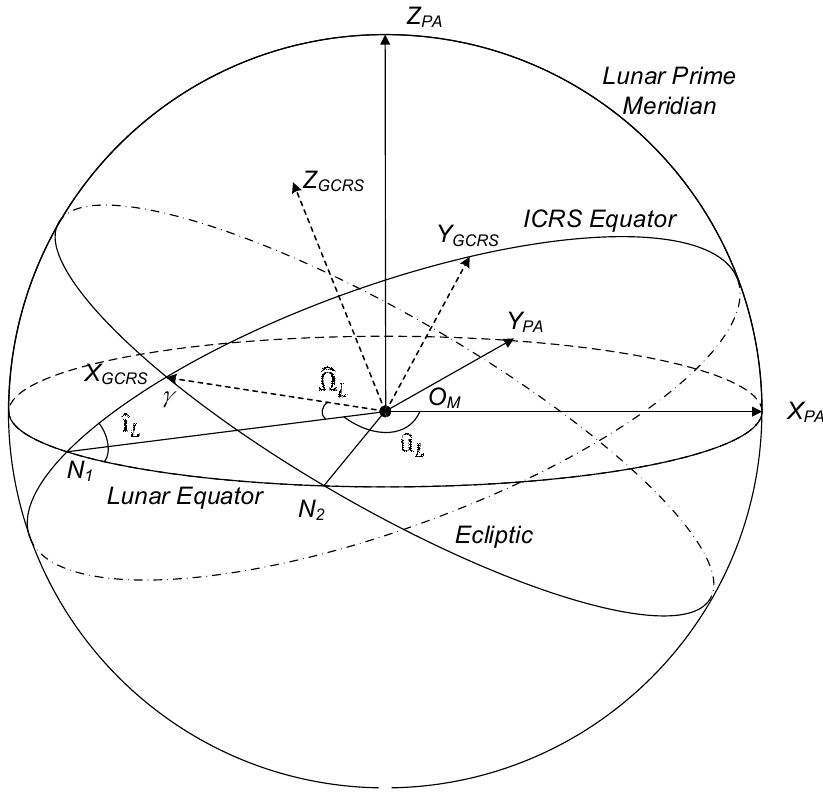
Figure 2. The coordinate transforms on the celestial sphere.